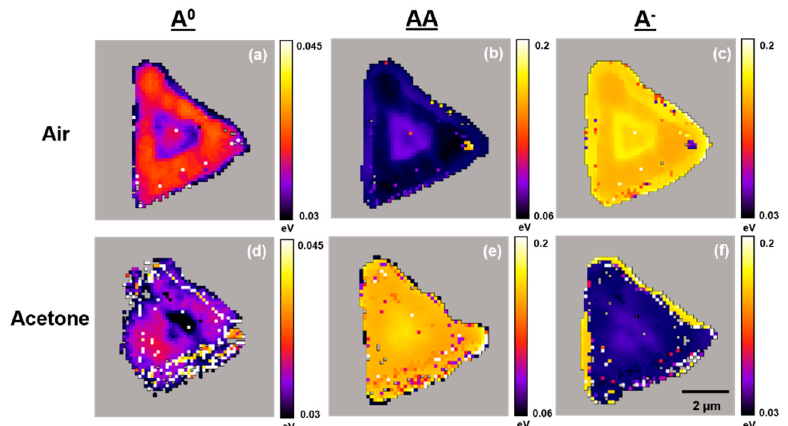
Figure 8. Typical PL emission A 0 , AA, and A − exciton band FWHM (eV) maps for a WS 2 flake on TSG